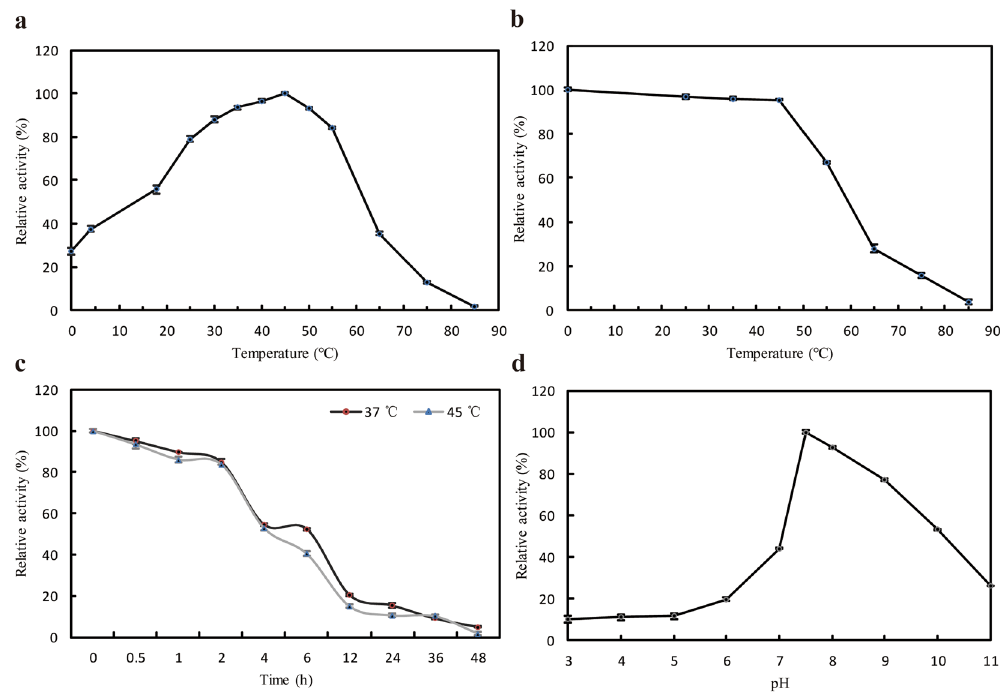
Figure 3. Characterization of AiiK. ( a ) Optimum temperature for enzyme activity. ( b ) Temperature stability of AiiK. ( c ) Thermostability of AiiK at 37 °C and 45 °C. ( d ) Effect of pH on AiiK. All experiments were carried out in triplicates.